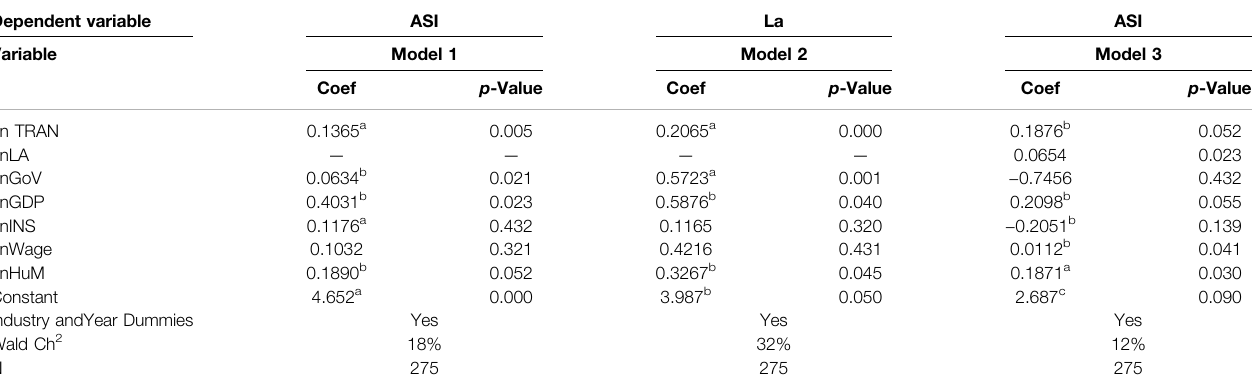
TABLE 4 | Robustness